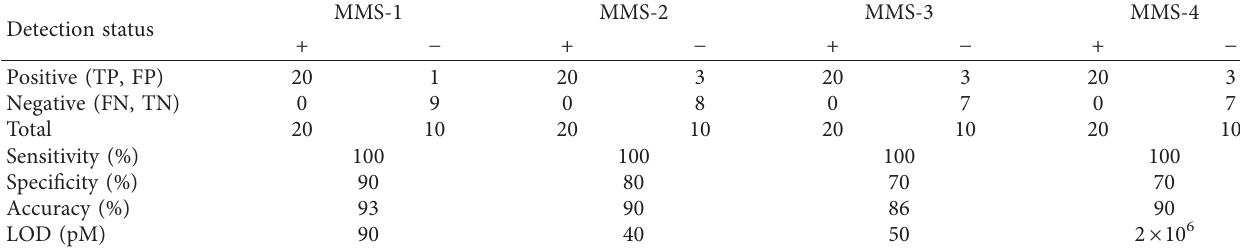
Table 1: Calculated analytical sensitivity, specificity, accuracy, and LOD of the microspheres in miRNA detection.